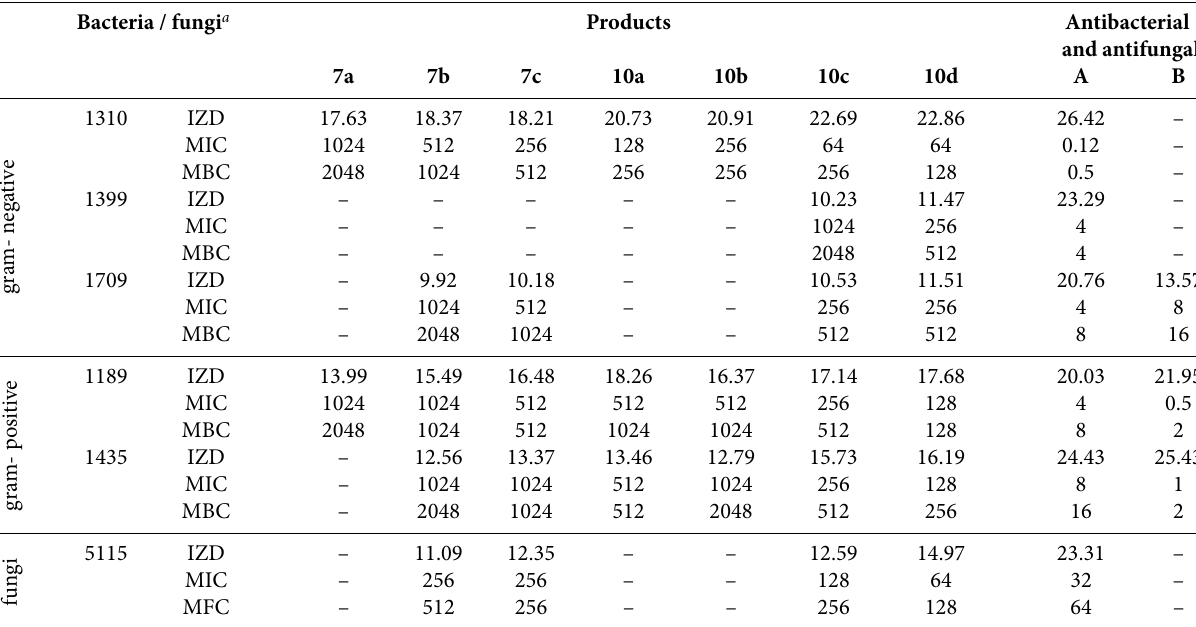
Table 2. Antimicrobal activities of derivatives 7a – c and 10a – d against Gram-negative, Gram- positive pathogenic bacteria and Fusarium oxysporum . Bacteria / fungi